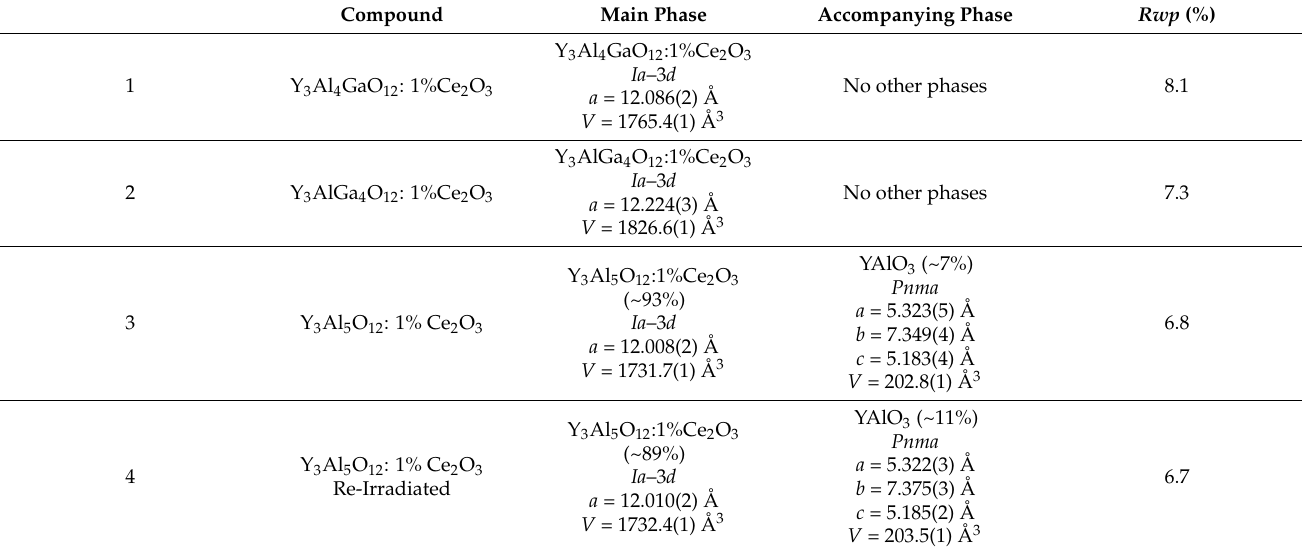
Table 1. Results of studying the phase composition of the samples.